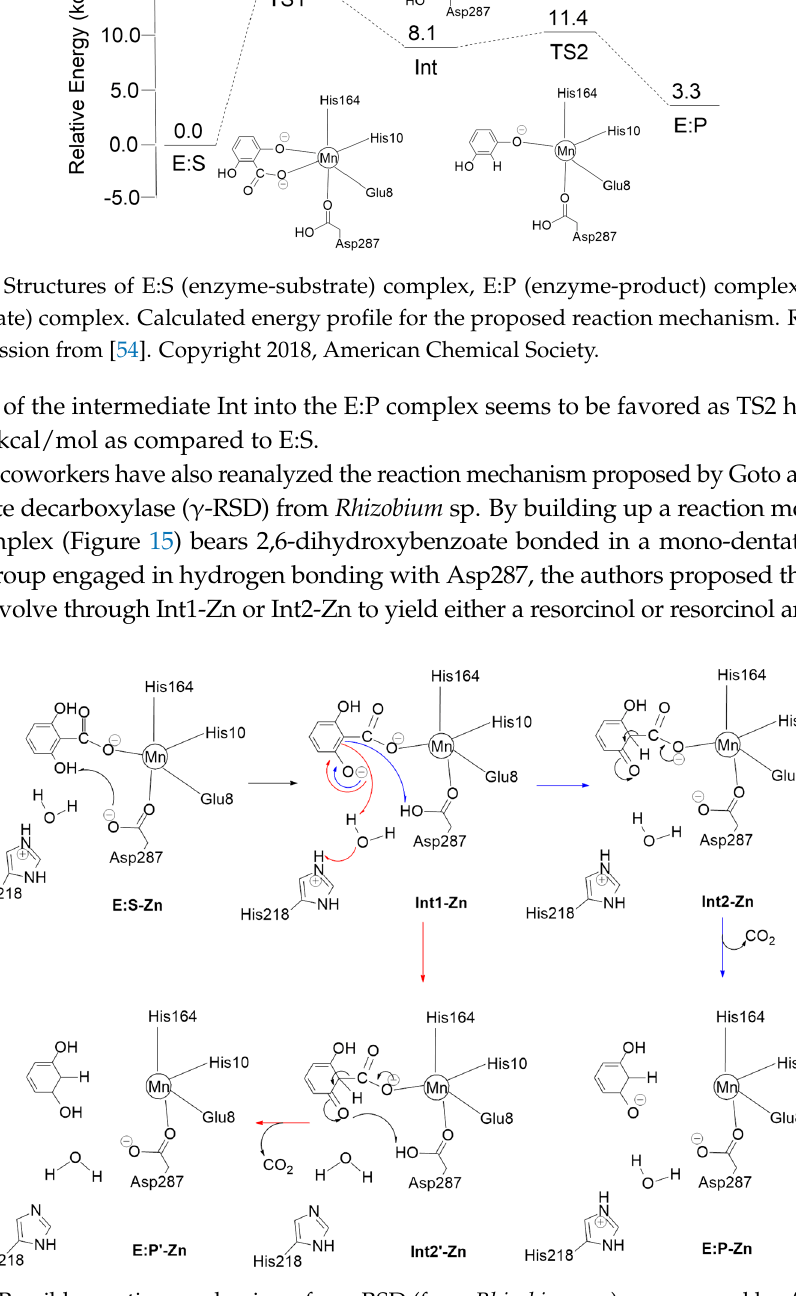
Figure 15. Possible reaction mechanisms for γ -RSD (from Rhizobium sp.) as proposed by Almo and coworkers. Orange curly arrows in Int1-Zn show the movement of electron pairs affording Int2’-Zn. Blue curly arrows in Int1-Zn show the movement of electron pairs affording Int2-Zn. Adapted with permission from [54]. Copyright 2018, American Chemical Society.